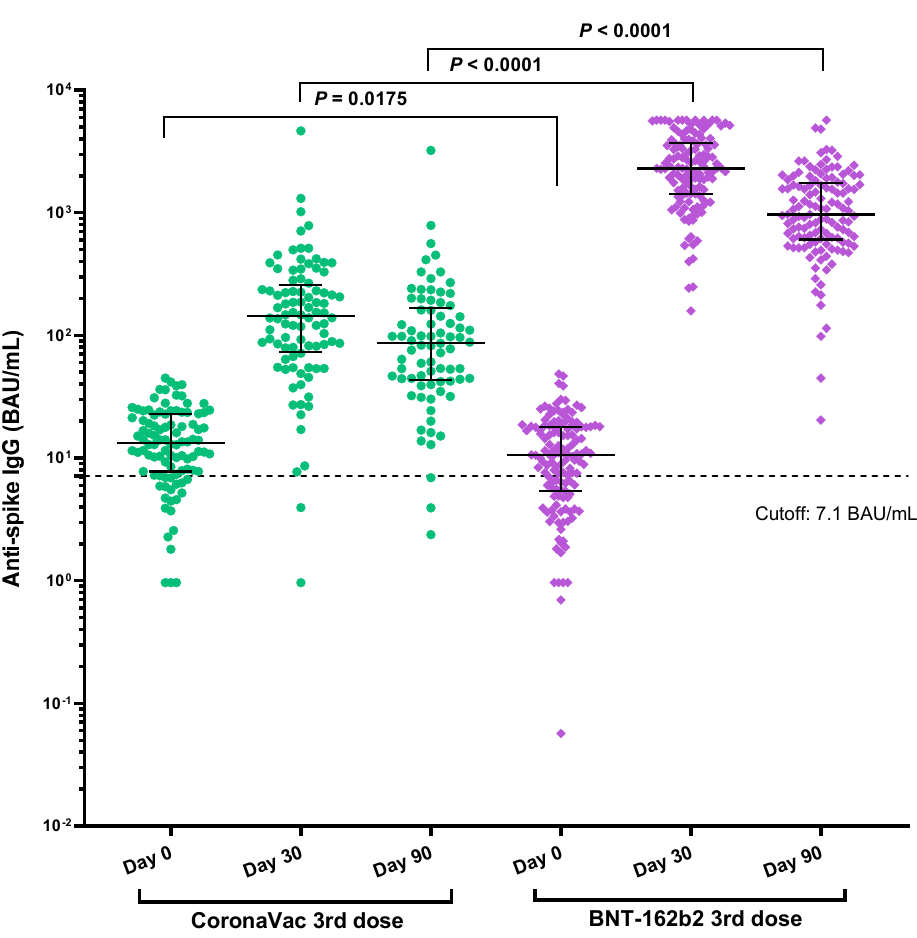
Figure 2. Comparison of immunogenicity of CoronaVac and BNT162b2 booster vaccination by quantitative anti-spike IgG. Number of samples at day 0, day 30 and day 90 of CoronaVac (N = 98, 92, 77) and BNT162b2 (N = 136, 130, 126), respectively. Median and p -values were tested using a Mann-Whitney test (By Prism GraphPad Software).